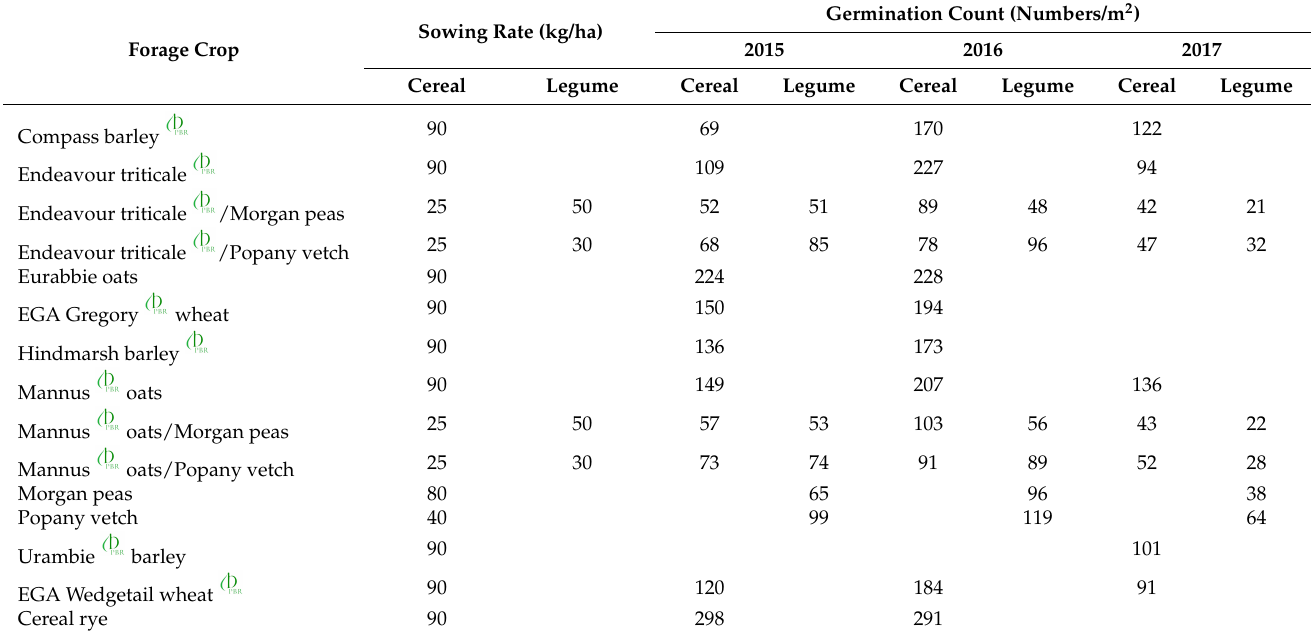
Table 1. Sowing rates and germination counts for winter forage crops grown in 2015–2017 at Wagga Wagga, NSW. Sowing Rate (kg/ha) Forage Crop